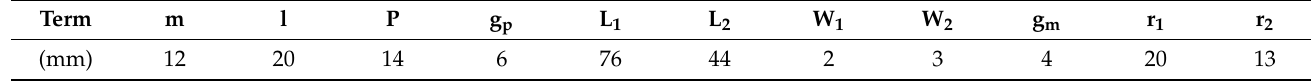
Table 1. Antenna dimensions for the proposed structure of